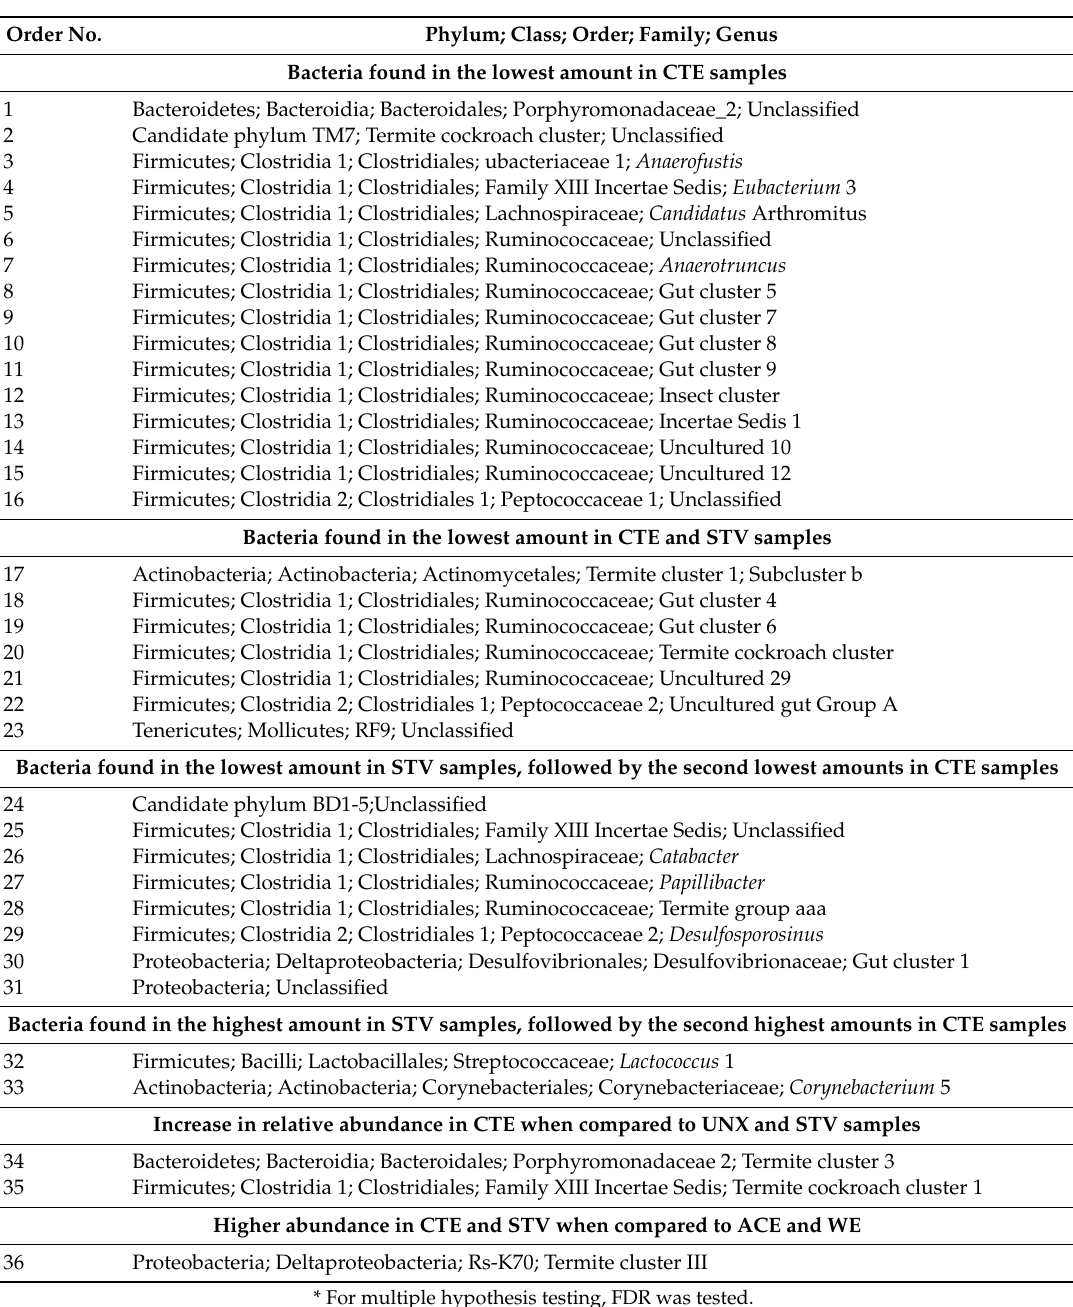
Table 4. Taxonomic classification of identified genus-level bacteria and statistical di ff erences in their relative amounts as a ff ected by diet